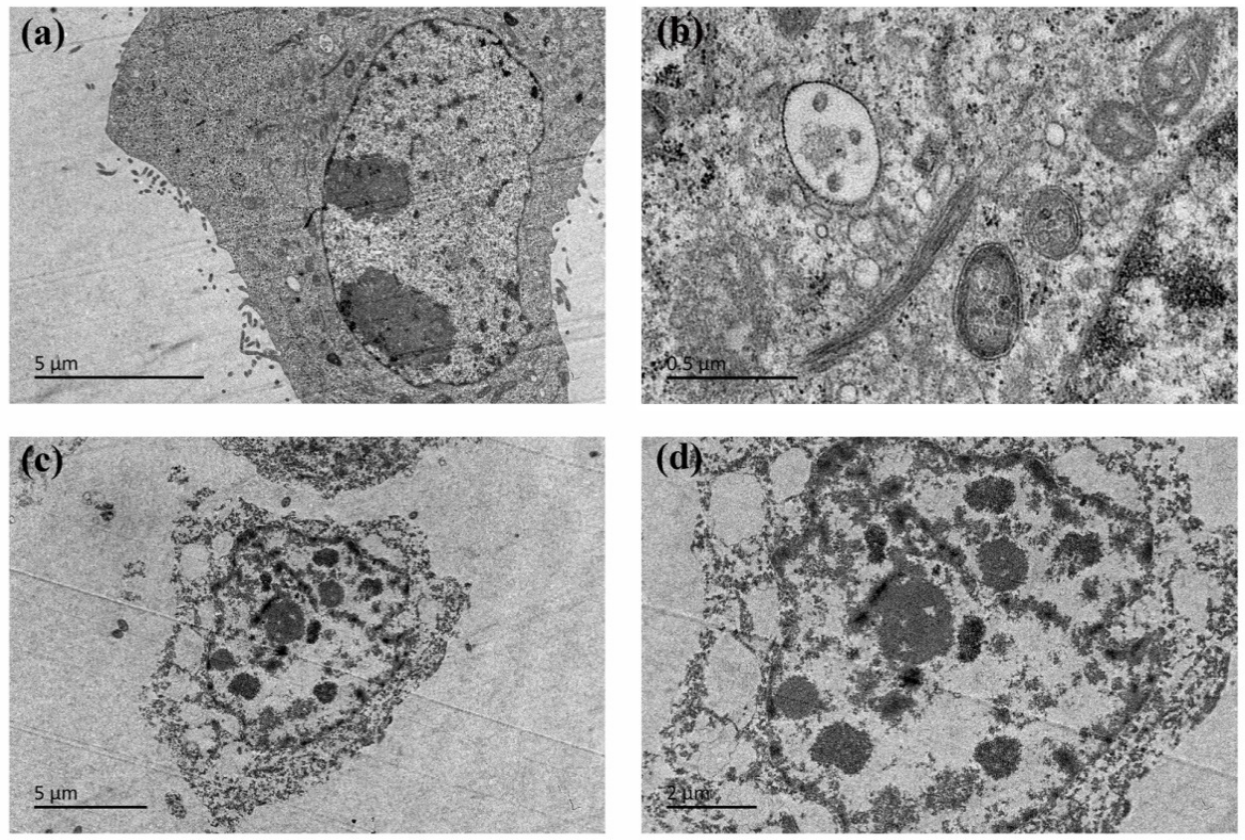
Figure 4. Cell morphology of the MCF-7 cell line with 4b after treatment for 24 h. ( a , b ) Control group, ( c , d ) treated with 0.4 µ M of the 4b for 24 h.